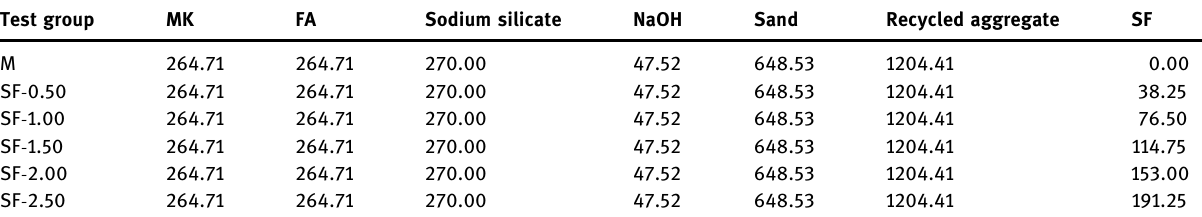
Table 7: FRGRAC mix proportion ( kg · m − 3 ) Test